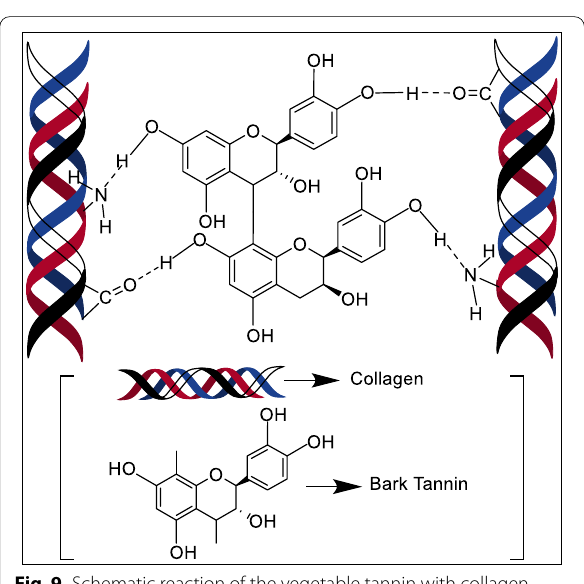
Fig. 9 Schematic reaction of the vegetable tannin with